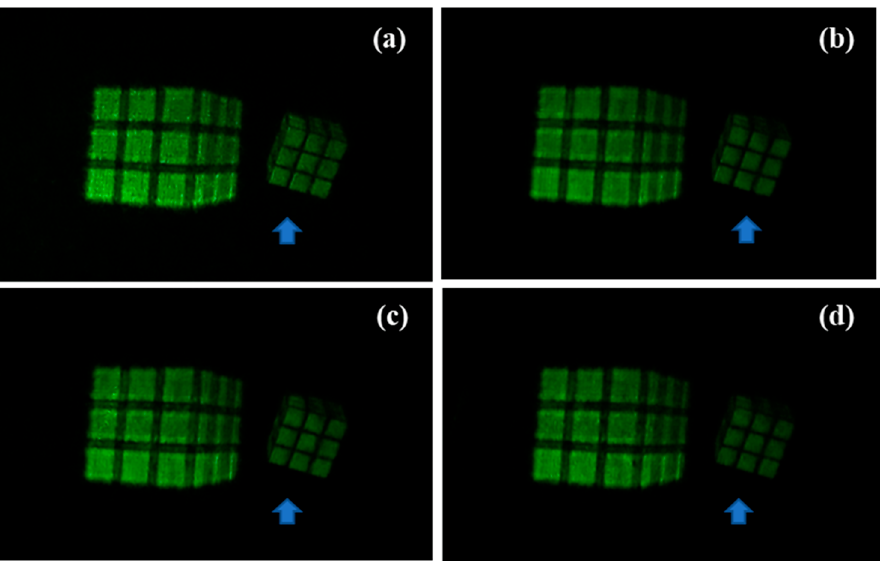
Figure 10. Experimental optical observations reconstructed from each hologram in the case of CAO encoding ( a ), MAO encoding ( b ), Burckhardt’s encoding ( c ), and Lee’s encoding ( d ) where the left eye of the observer is focused on the back-positioned 3D cube that each arrow